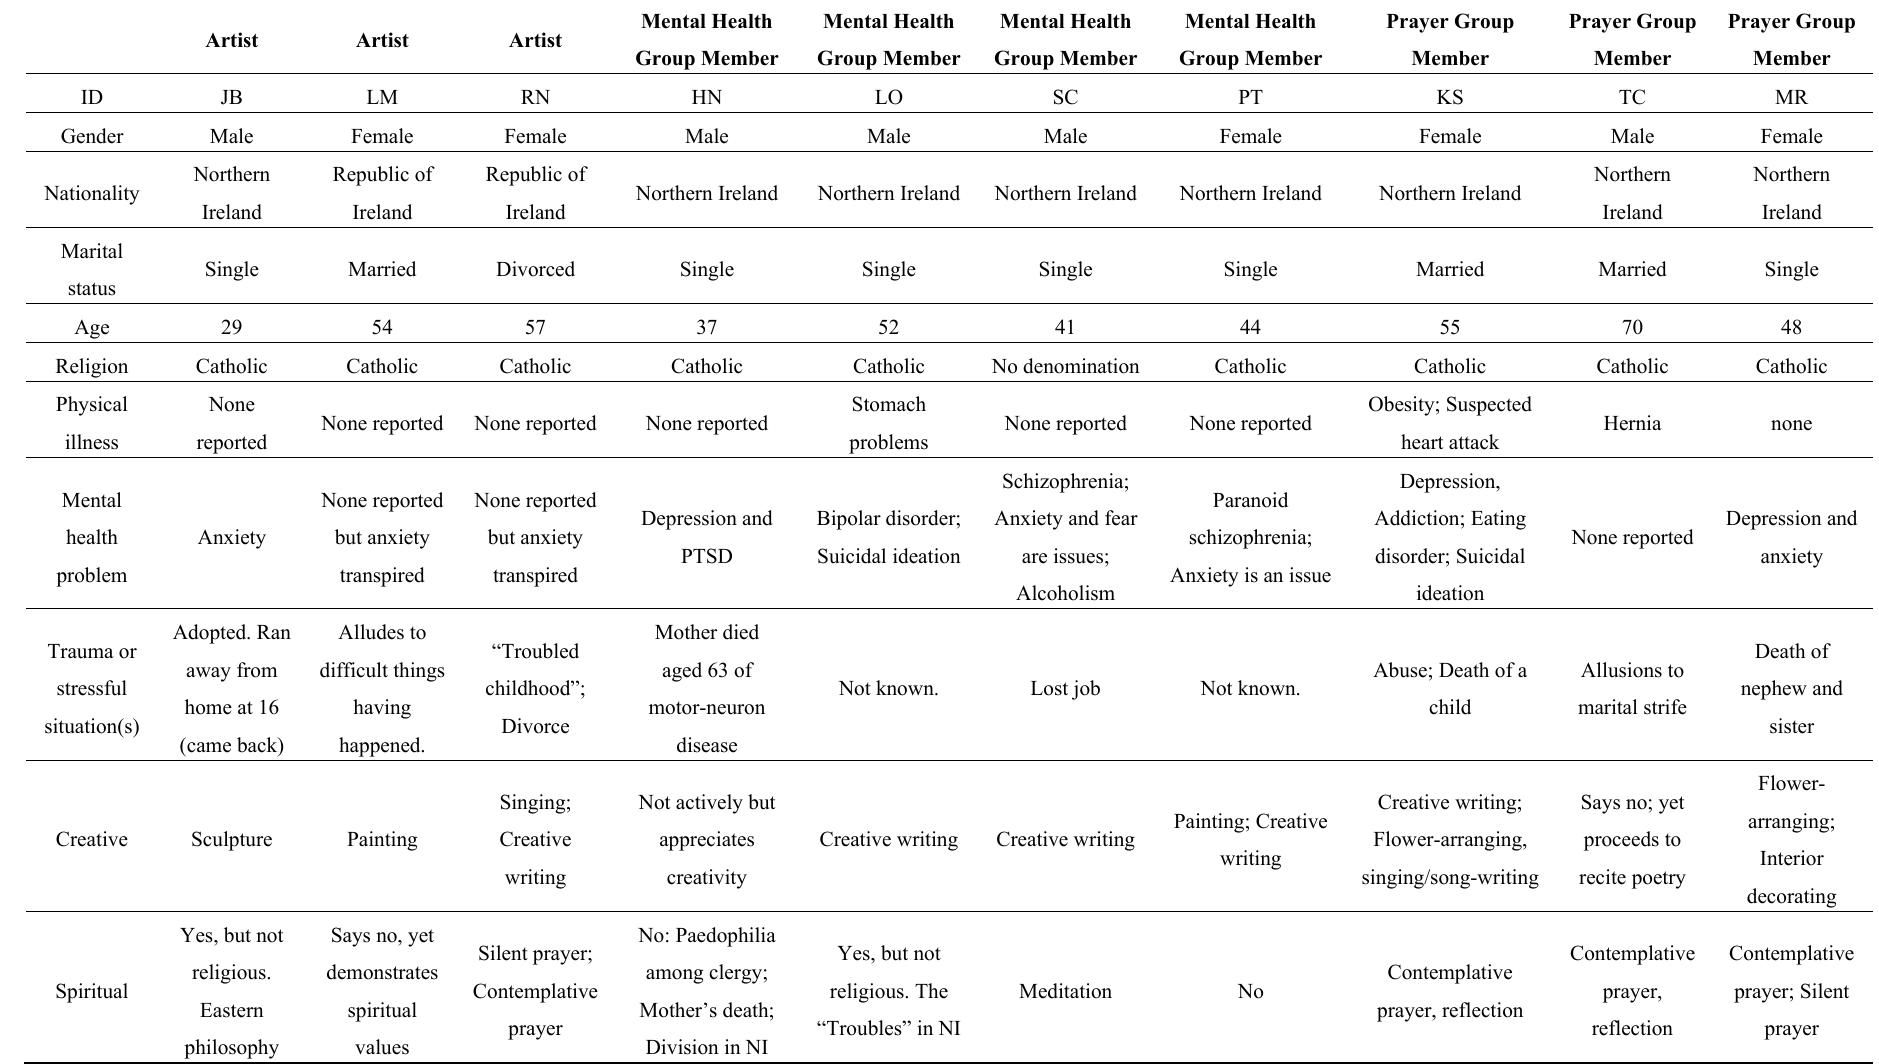
Table 1. Participants’ commonalities and